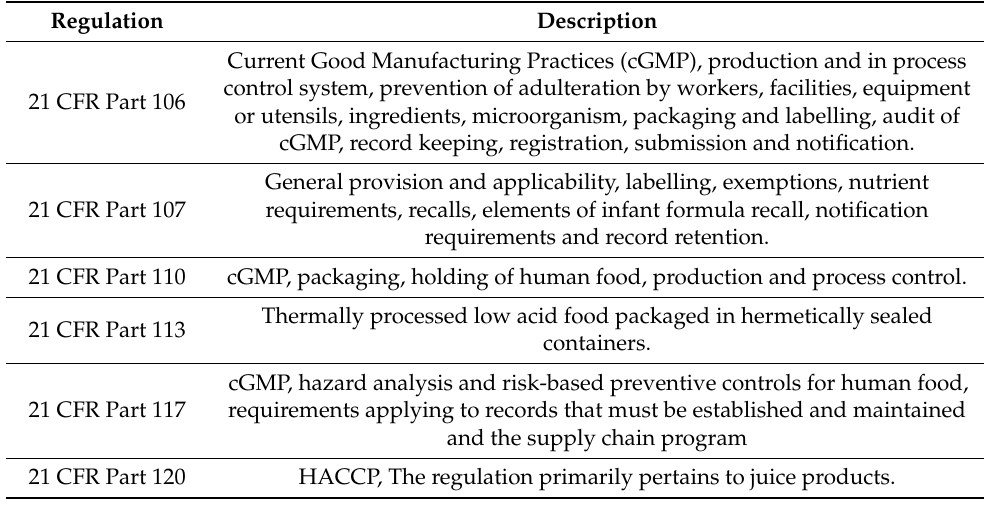
Table 5. Code of Federal Regulations (CFR) for the manufacturing of infant formula